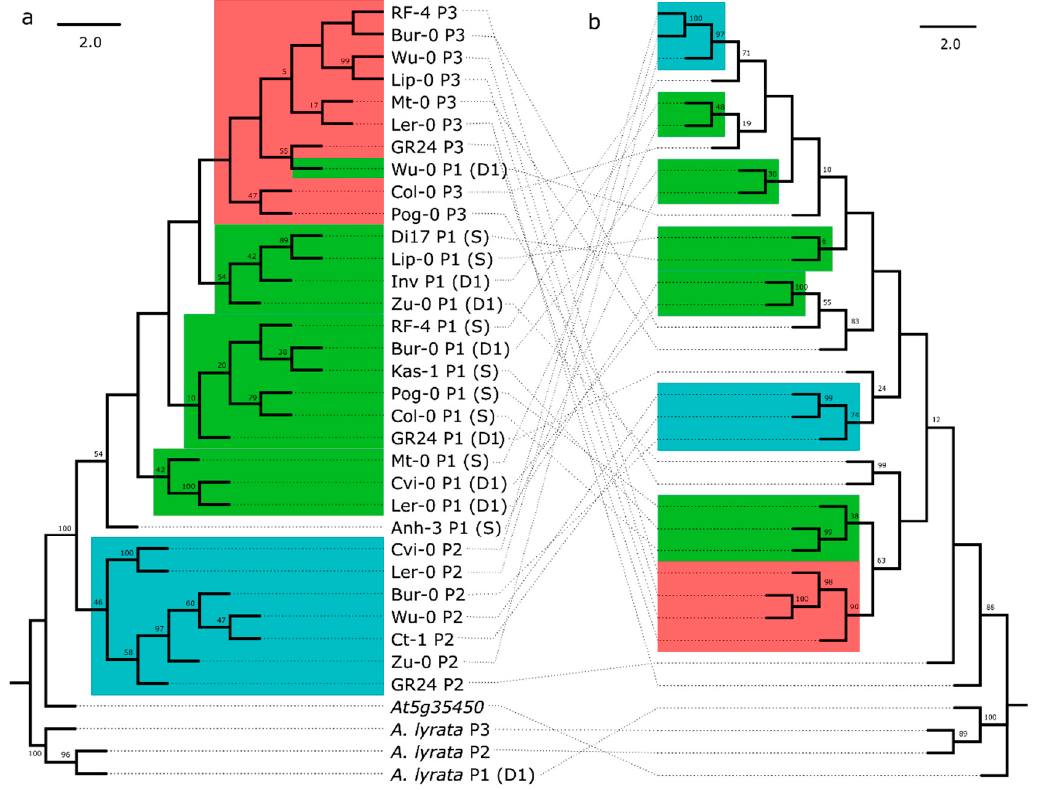
Figure 2. Bootstrap consensus trees for the maximum parsimony phylogenies of the leucine-rich repeat region (LRR) and non-LRR regions of the three RPP8 paralogs, P1, P2, and P3. Clades comprised of alleles from one paralog are boxed. Green, blue, and orange boxes represent P1, P2, and P3, respectively. The percentage of replicate trees in which the associated taxa clustered together in the bootstrap test (5000 replicates) are shown next to the branches; values less than 5 are not shown. ( a ) Sequence similarity tree of the non-LRR region. 239 out of 1701 sites were parsimony informative. ( b ) Sequence similarity tree of the framed LRR region for the same accessions as in ( a ). In total, 236 out of 1019 sites were parsimony informative.